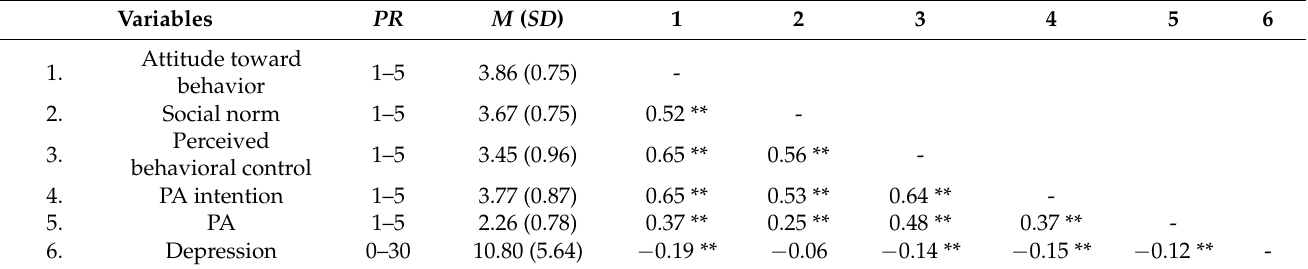
Table 1. Descriptive statistics and correlations among study variables ( n =